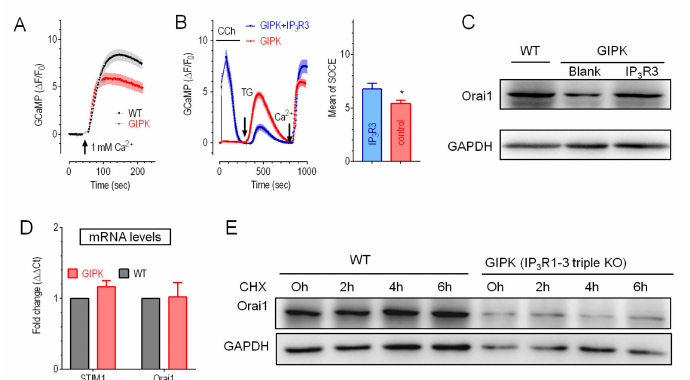
Figure 3. Characterization of SOCE and Orai1 protein levels in IP 3 Rs-TKO cells. ( A ) Typical TG-induced SOCEresponsesofHEKGIPKorWTGCaMPcellsmeasuredwithcytoplasmicCa 2 +